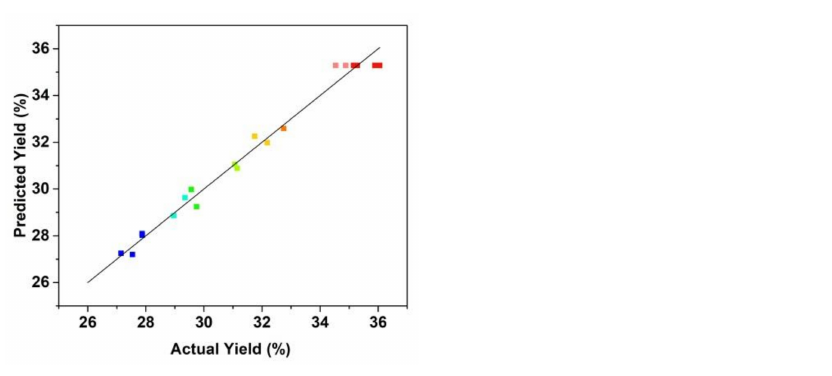
Figure 4. Correlation of actual and predicted yield of the prepared Cornus officinalis peptides